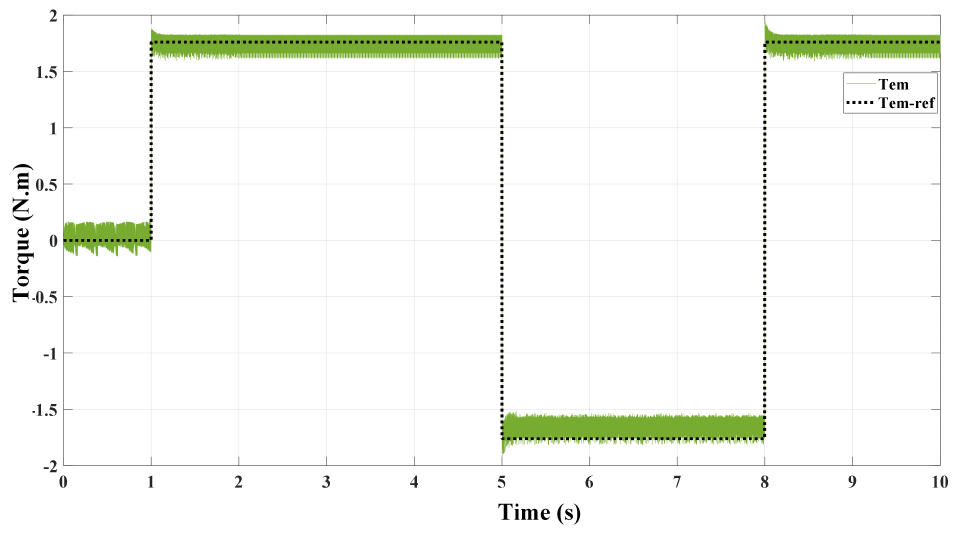
Figure 8. The torque response in the proposed